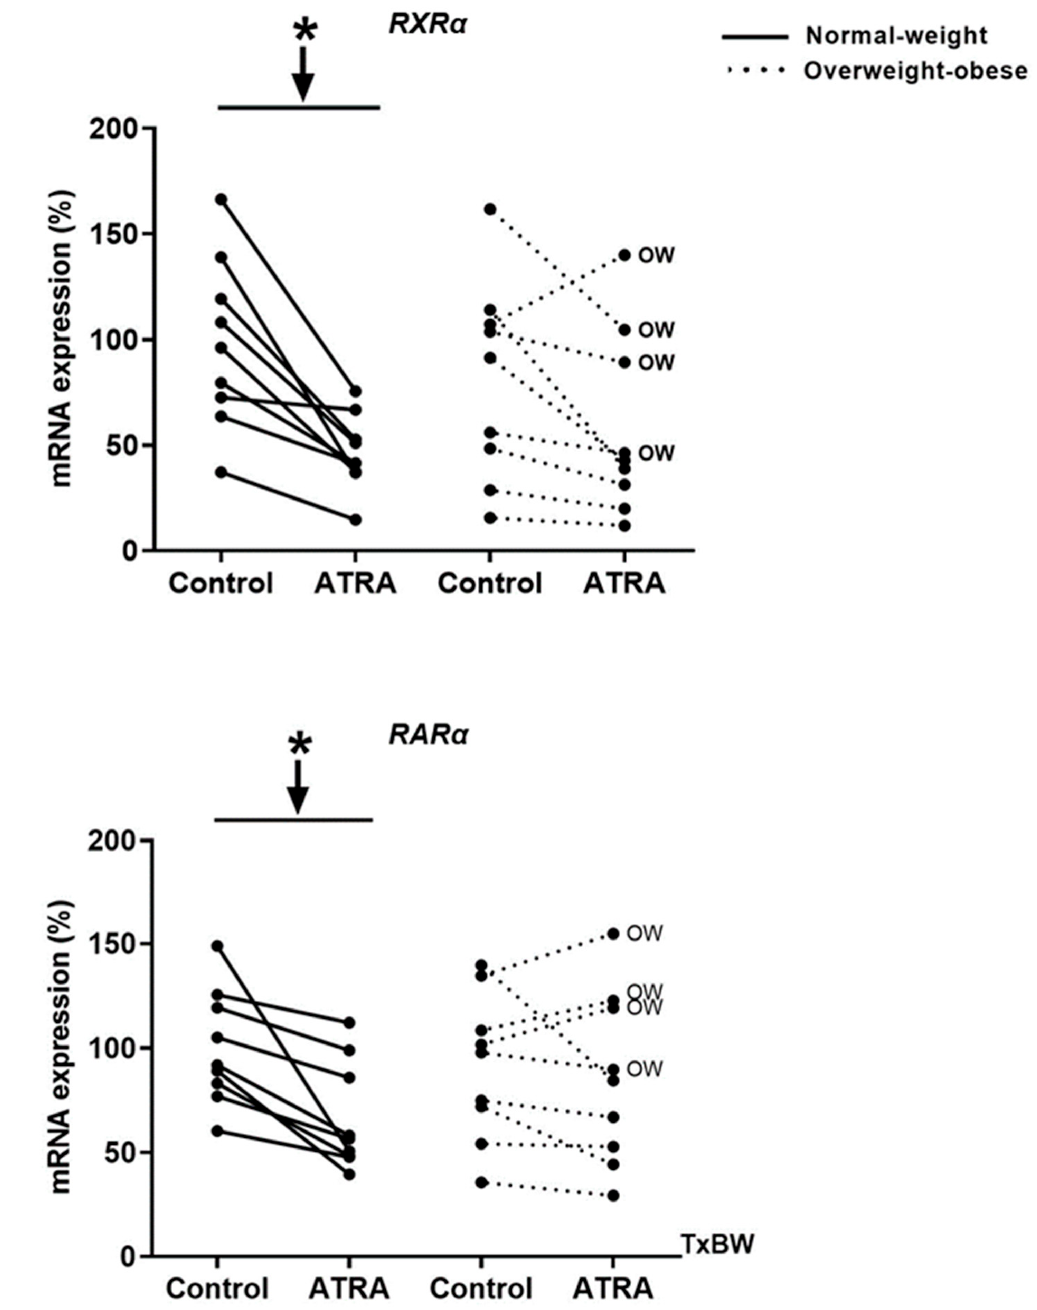
Figure 2. E ff ect of ATRA treatment on the mRNA levels of retinoid receptors ( RXR α and RAR α ) in isolated PBMCs from NW and overweight-obese (OW-OB) individuals, measured by real-time RT-qPCR. Isolated PBMCs were treated for 48 h with a vehicle control (ethanol) or 10 µ M ATRA in the presence of CD3 / CD28 magnetic beads. All data are presented as individual responses and represent means of 3 replicates per subject and condition. mRNA levels were normalized to RPLP0 and expressed relative to vehicle-treated cells. * p < 0.05 was calculated using a paired t -test. Two-way repeated measures ANOVA was performed to compare the di ff erent e ff ect of treatments and body weight on gene expression. T × BW, interactive e ff ect between treatment and body weight of PBMC donors (detailed results are shown in Table 2A). OW indicates the overweight subjects within individuals of the overweight-obese group. Down arrows represent decreased